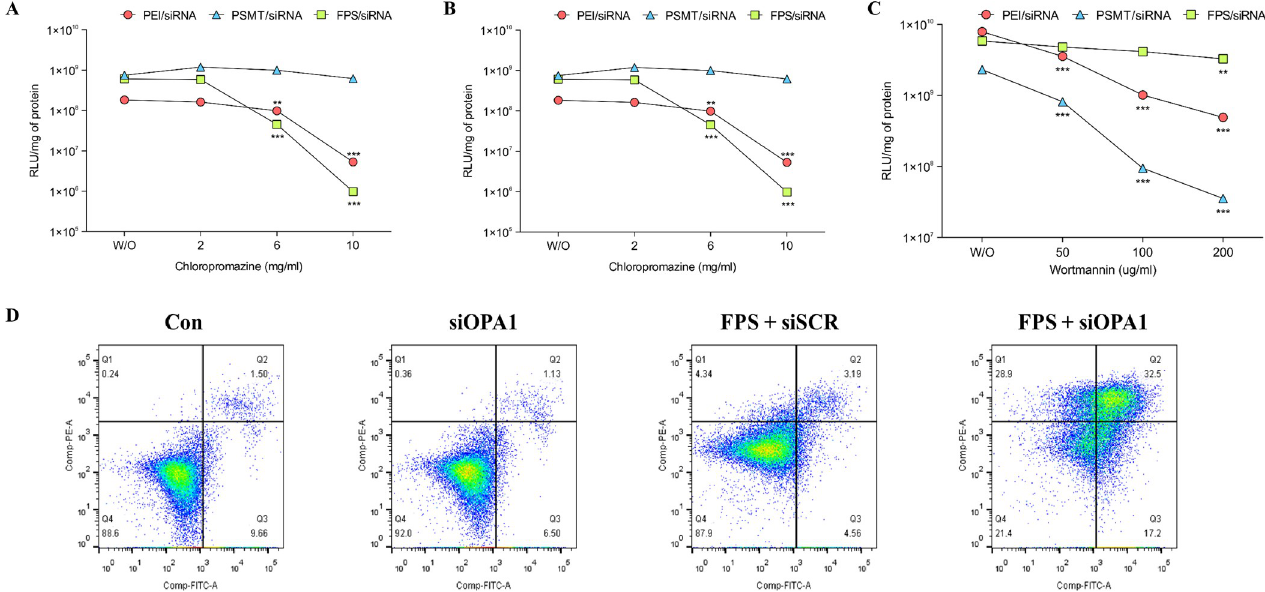
Fig 3. Endocytosis inhibitors on transfection efficiency of FPS/siRNA complexes and measurement of induced apoptosis by siOPA1. (A)-(C) Endocytosis inhibitors on transfection efficiency of FPS/siRNA complexes. Cells pre-incubated with various amount of chloropromazine, genistein, and wortmannin were transfected with PEI, PSMT, and FPS/siRNA complexes (N/P ratio 20) and luciferase assay was conducted. (n = 3, one-way ANOVA; � p < 0.1; �� p < 0.05; ��� p < 0.01, compared to that of control without inhibitor), (D) Measurement of induced apoptosis by siOPA1, All groups combined annexin-V and viability dyes PI in A549